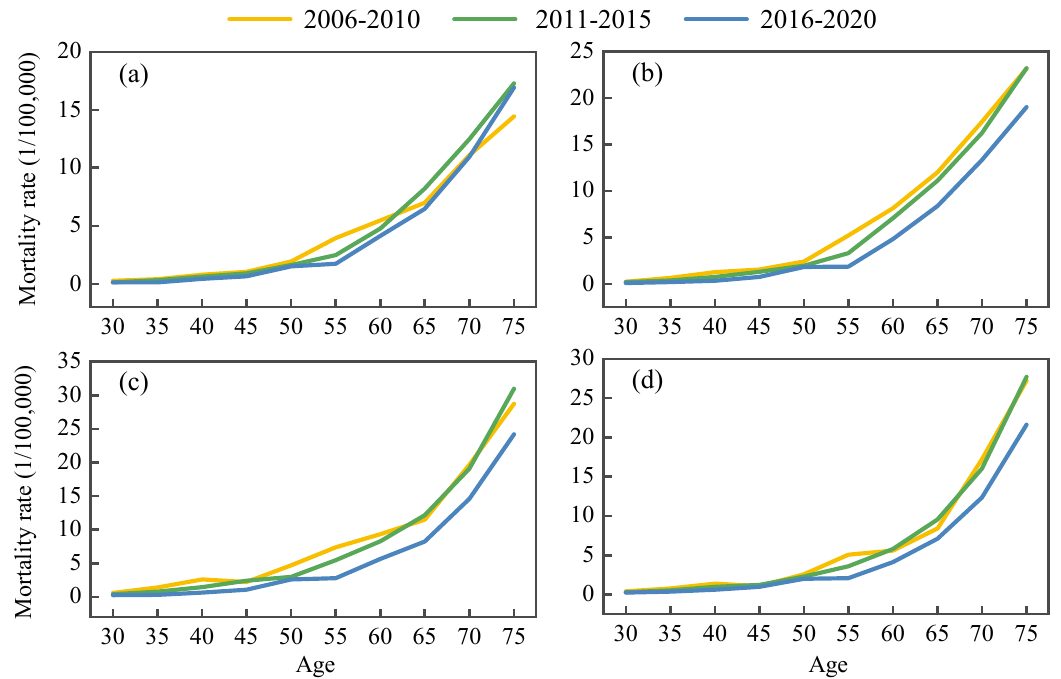
Figure 3. Mortality rates of RHD in China from 2006 to 2020. Mortality data were collected from the Disease Surveillance Points system of China. Age analyses were from 30 to 79, with every 5–year interval as one age. ( a ) Urban male, ( b ) urban female, ( c ) rural male, ( d ) rural